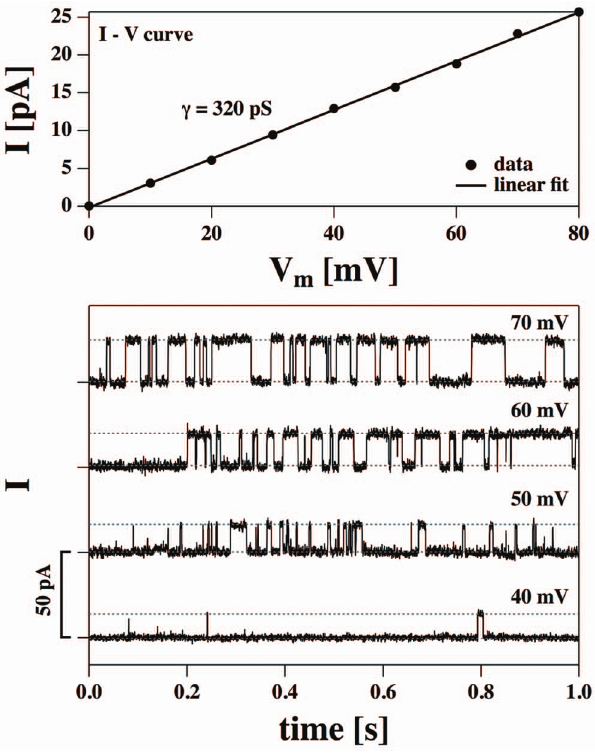
Figure 3. Recordings of the DMPC:DLPC=10:1 membrane from Fig. 2 as a function of voltage (cf. Fig. 2, panel C4). Bottom: Current-traces for a DMPC:DLPC=10:1 mol/mol membrane (150 mM KCl, T=30 u C) at four voltages showing an increase of single-channel conductance with voltage and an increased likelihood of channel formation. Top: The corresponding linear single-channel current- voltage relation indicating a single-channel conductance of c =320 pS.